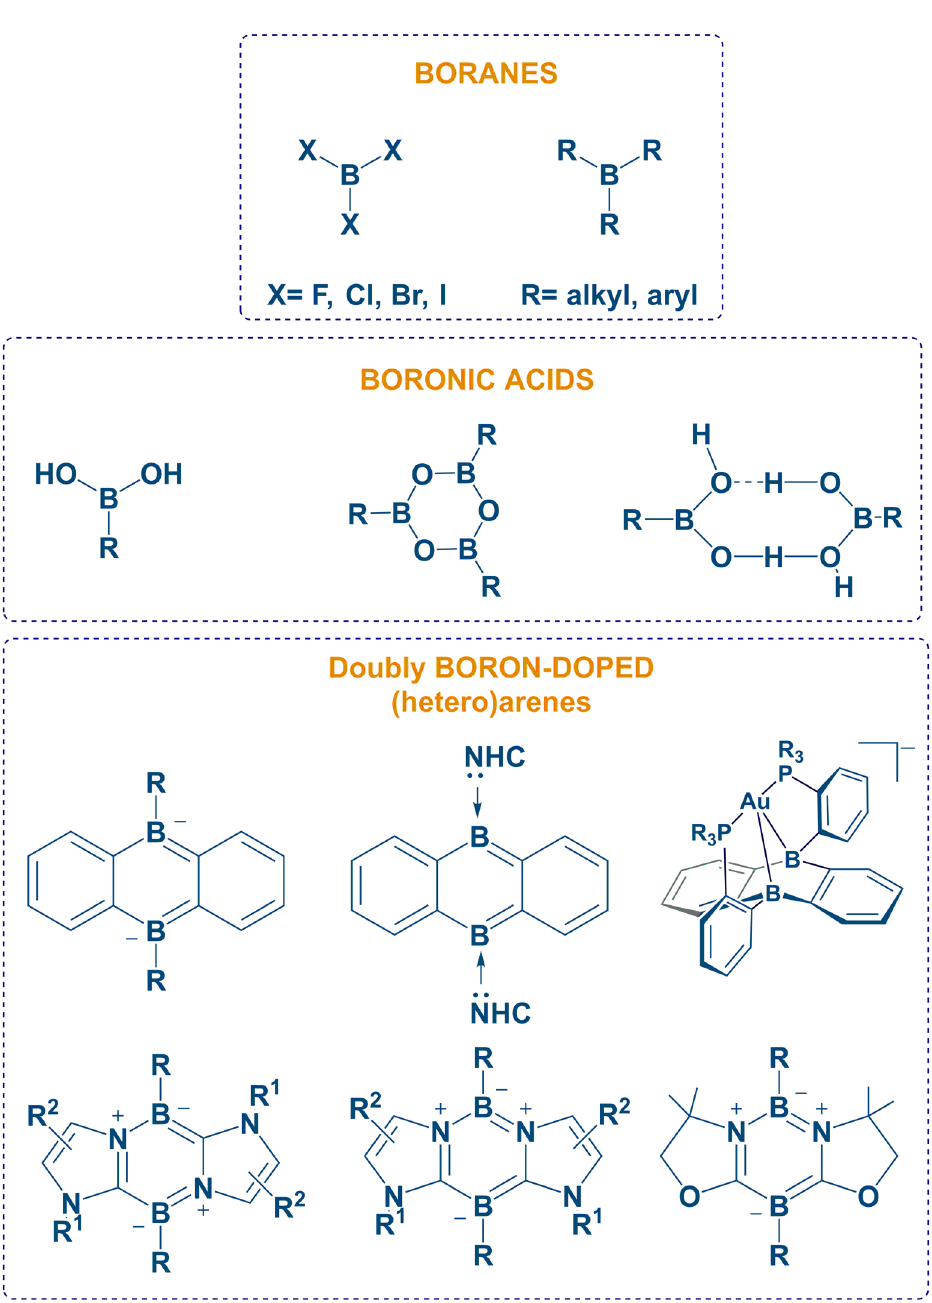
Figure 2. Different classes of boron-based catalysts.